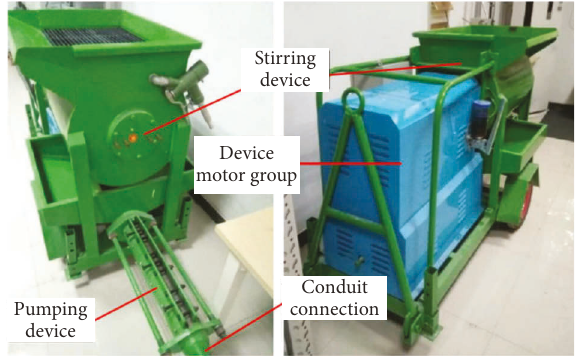
Figure 6: Examples of common feeding systems